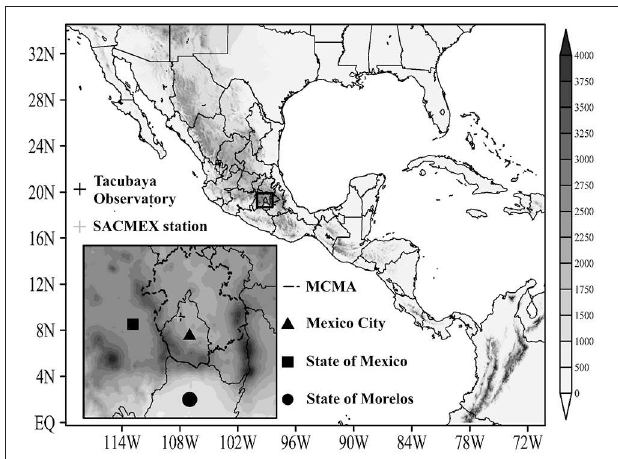
FIGURE 3 | The domain used in WRF experiments. Topography in shaded